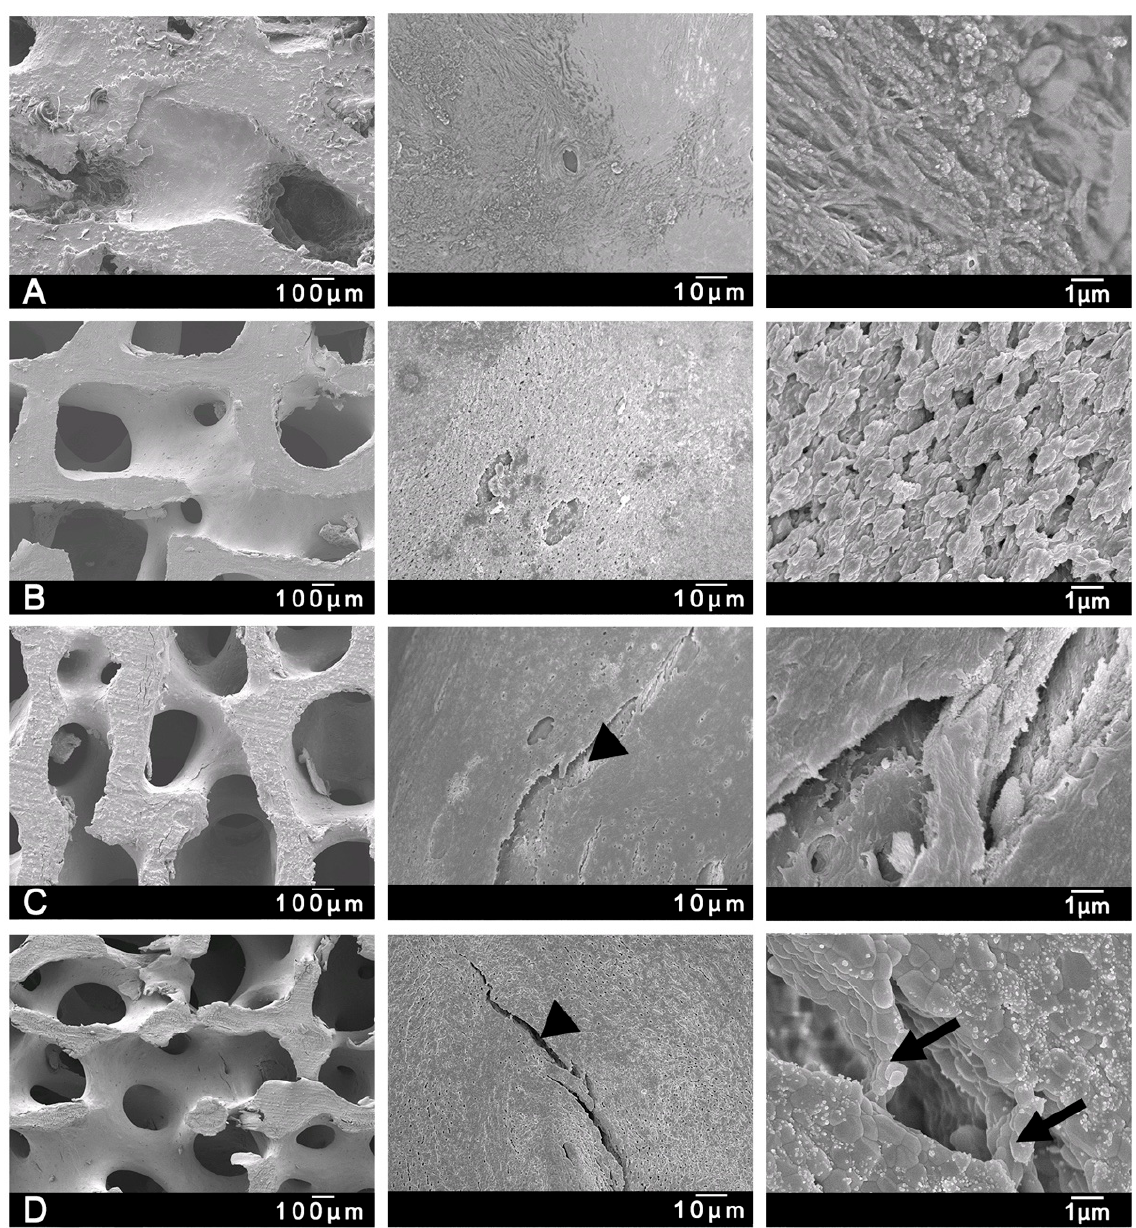
Figure 4. SEM micrographs of the different groups of bovine bone blocks. ( A ) Raw bone, ( B ) boil (6 h), ( C ) initial boiling (6 h) followed by 550 ◦ C sintering (6 h), ( D ) initial boiling (6 h) followed by 1100 ◦ C sintering (6 h). Arrows show crystal structures; arrow heads show microcracks (representative image of n = 2).